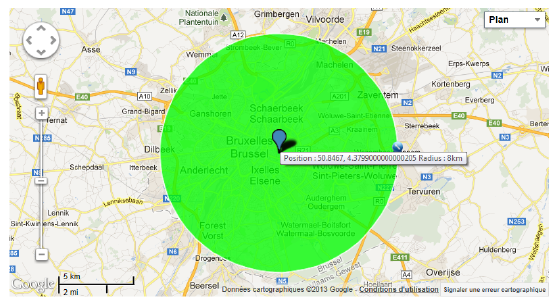
Figure 3. Defining the Brussels